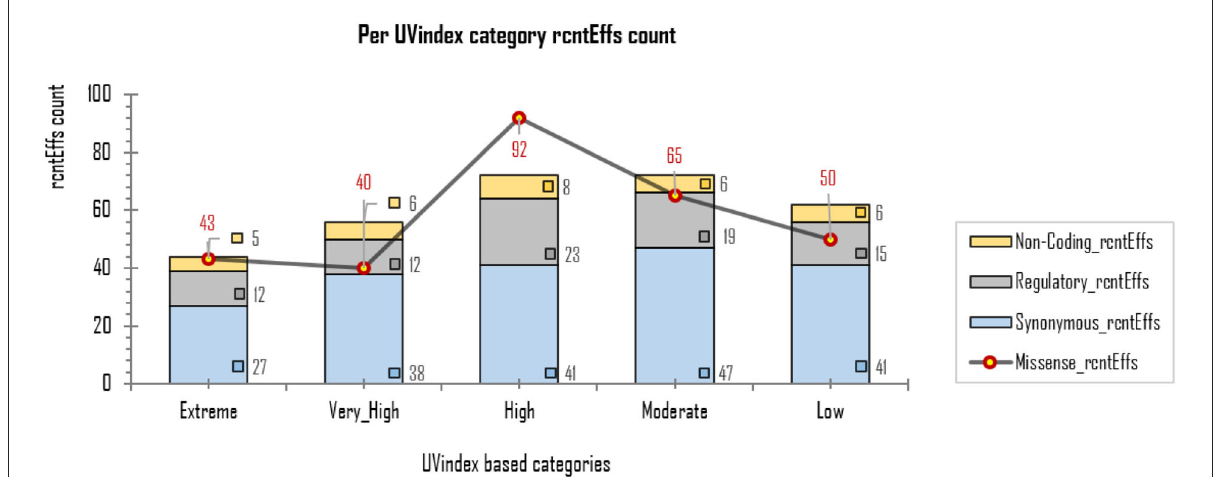
FIGURE5 Different functional effects (rcntEffs) predicted for all rcntSNVs in all five WHO’s defined UVindex categories are shown using a combo bar-line chart. The most prevalent rcntEffs missense are displayed using red-pointed gray line, whereas the synonymous, regulatory, and non-coding rcntEffs are represented here in blue-, gray-, and yellow-stacked columns, respectively.